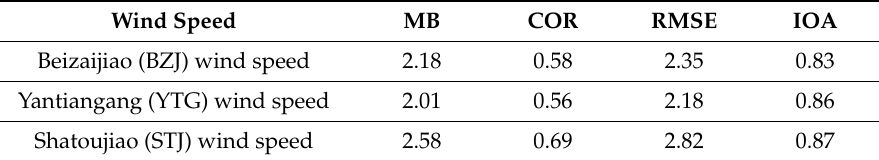
Table 3. Test statistics of the WRF